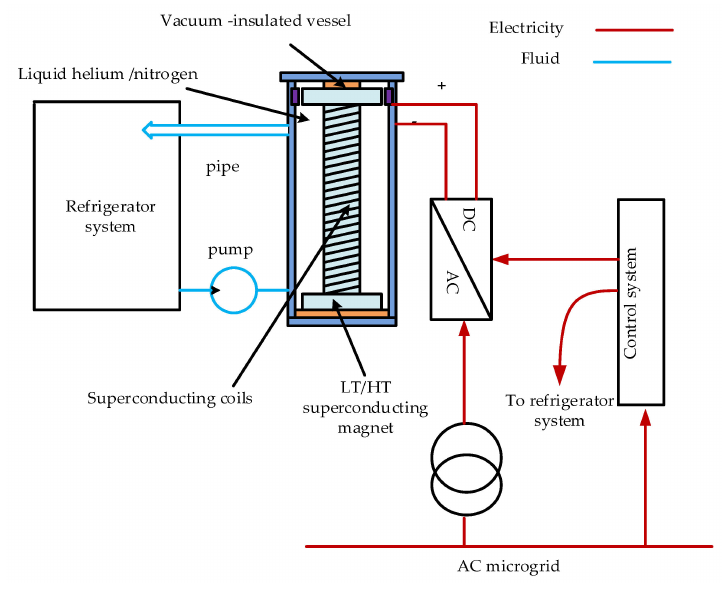
Figure 8. The SMES construction